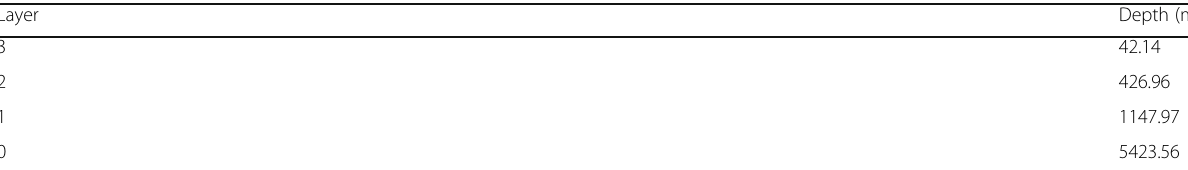
Table 6 different layers of the Earth with